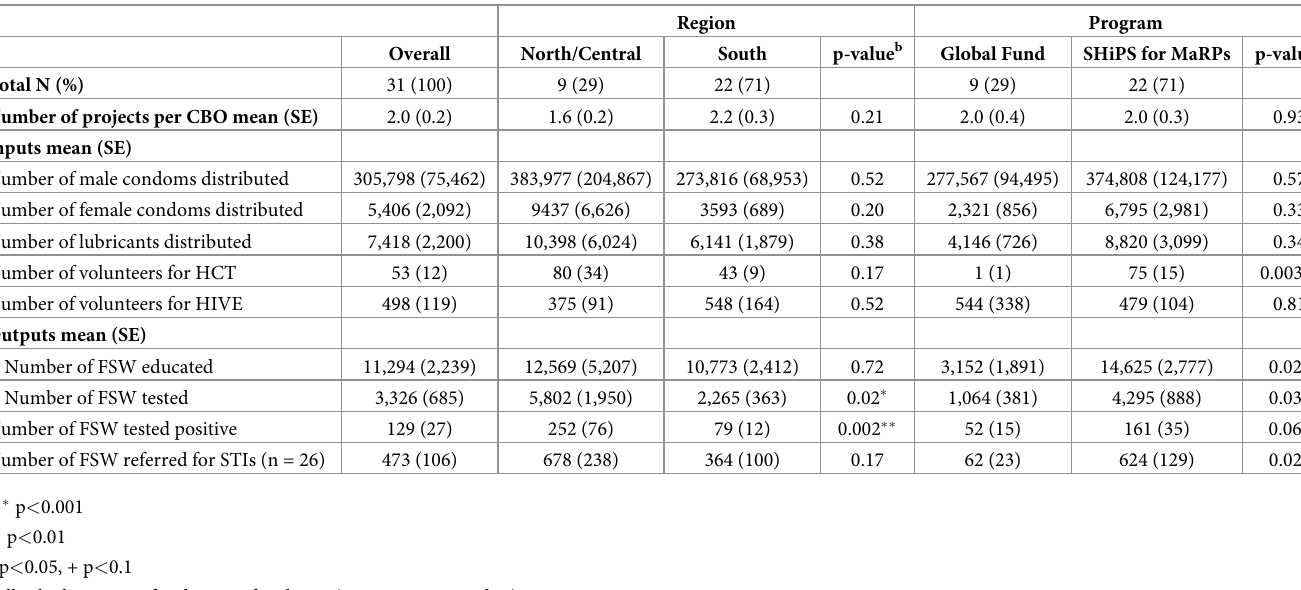
Table 1. Characteristics of a sample of community-based organizations in Nigeria in 2016, overall and by region a .